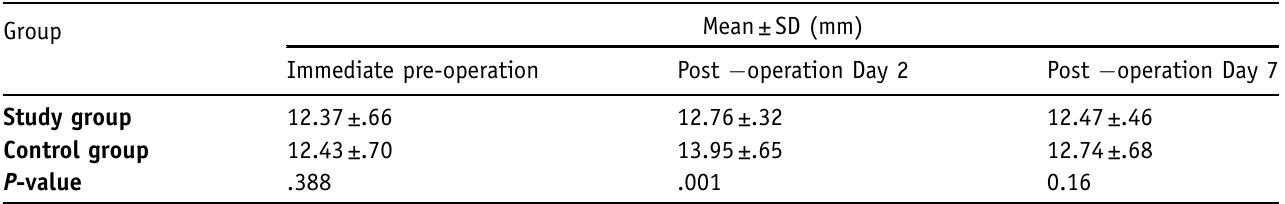
Table II. Evaluation of Swelling in this study as mean ± standard